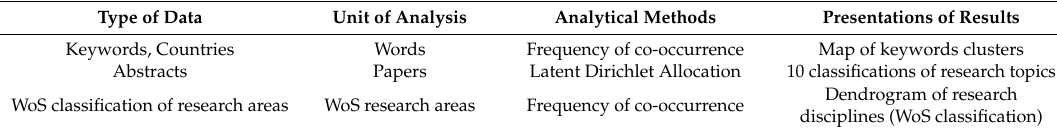
Table 1. Summary of techniques used for each type of